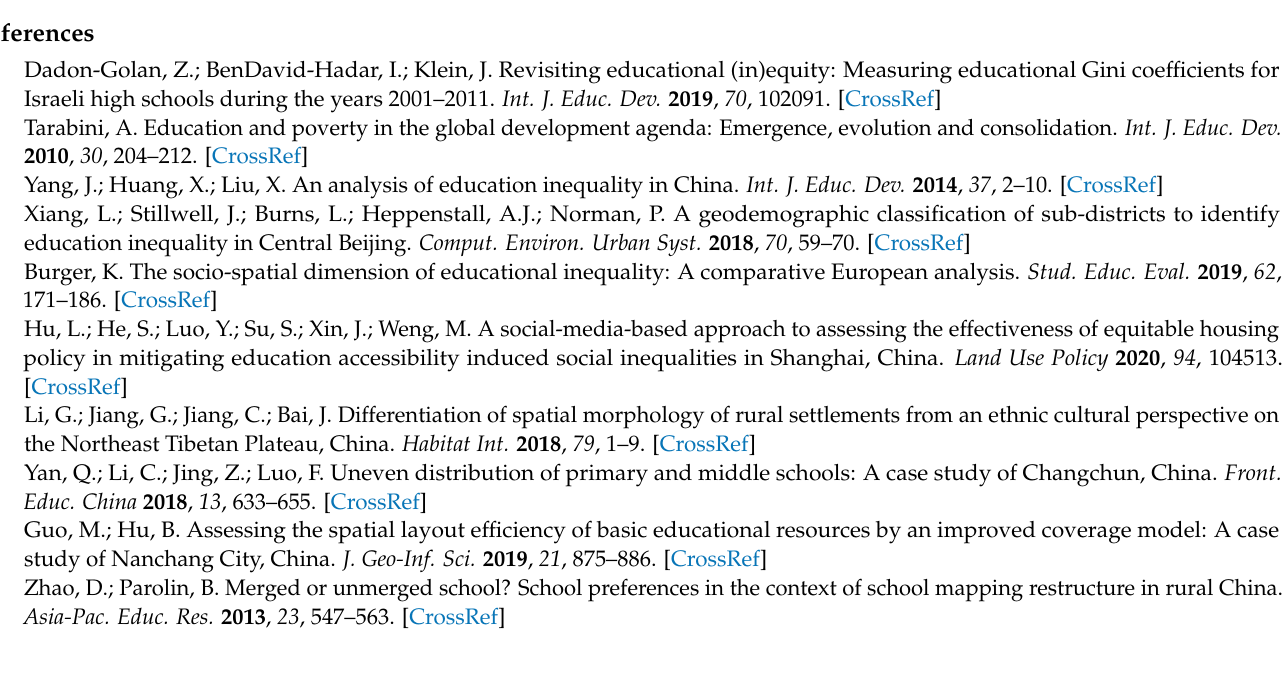
Figure A1. The SDE of PMSs in 38 basic units.